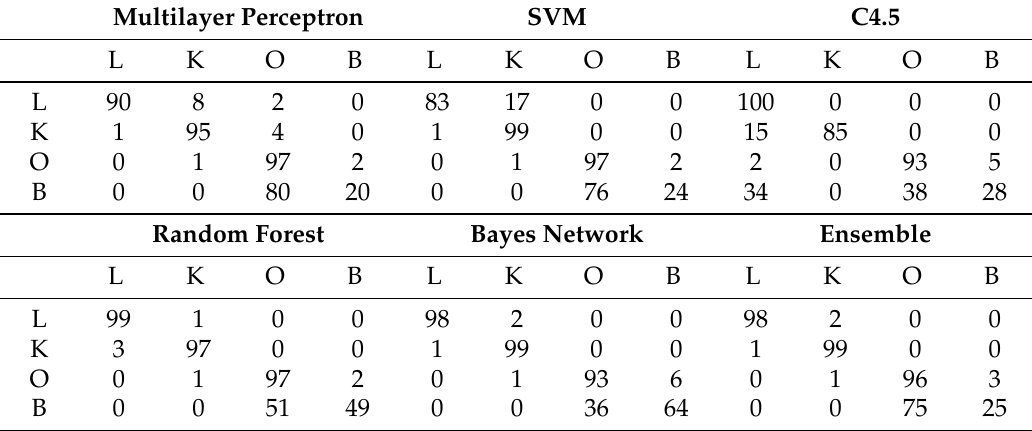
Table 6. Confusion matrix for the first scenario. The samples for training were taken with the user moving, and also moving for testing. The meaning of the capital letters are: L: Living-room, K: Kitchen, O: Office, B: Bathroom.